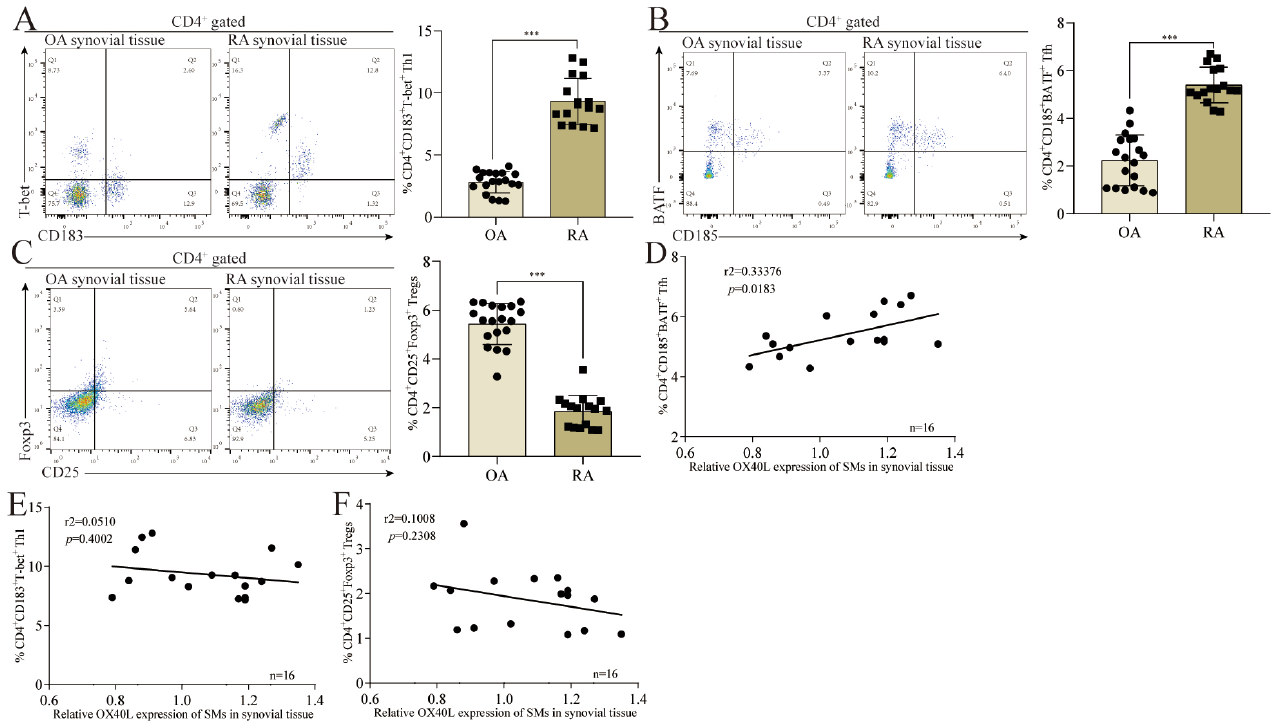
Figure 2. OX40L level in SMs is positively correlated with the proportion of Tfh in CD4 + T cells in the synovial tissues of RA patients. ( A ) The proportion of CD183 + T-bet + Th1 in CD4 + T cells in the syn- ovial tissues of RA patients. ( B ) The proportion of CD185 + BATF + Tfh in CD4 + T cells in the synovial tissues of RA patients. ( C ) The proportion of CD25 + Foxp3 + Tregs in CD4 + T cells in the synovial tissues of RA patients. ( D ) Correlation analysis of OX40L level in SMs with CD4 + CD185 + BATF + Tfh. ( E ) Correlation analysis of OX40L level in SMs with CD4 + CD183 + T-bet + Th1. ( F ) Correlation analysis of OX40L level in SMs with CD4 + CD25 + Foxp3 + Tregs. In ( A – C ), *** p < 0.001 represents a significant difference between the OA group and the RA group. Data represent mean ± SD (unpaired t test was used). In ( D – F ), p < 0.05 represents that the vertical coordinate is correlated with the horizontal coordinate; otherwise, there is no correlation (linear regression was